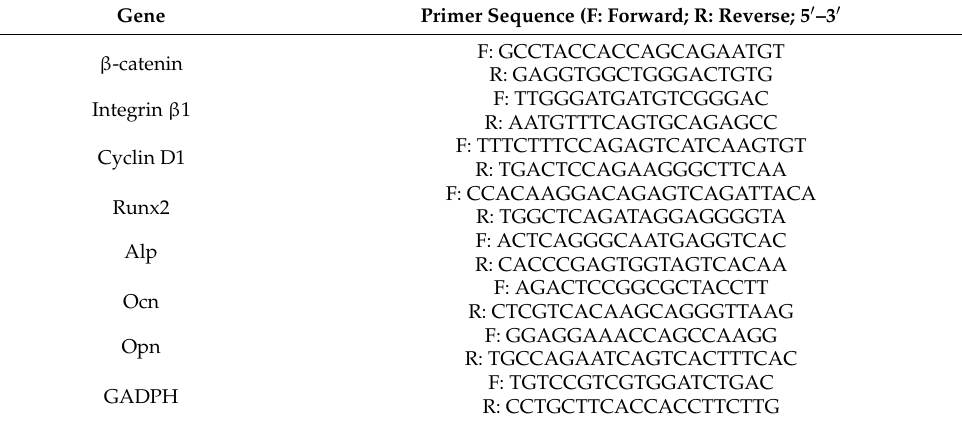
Table 1. Primer sequence of used